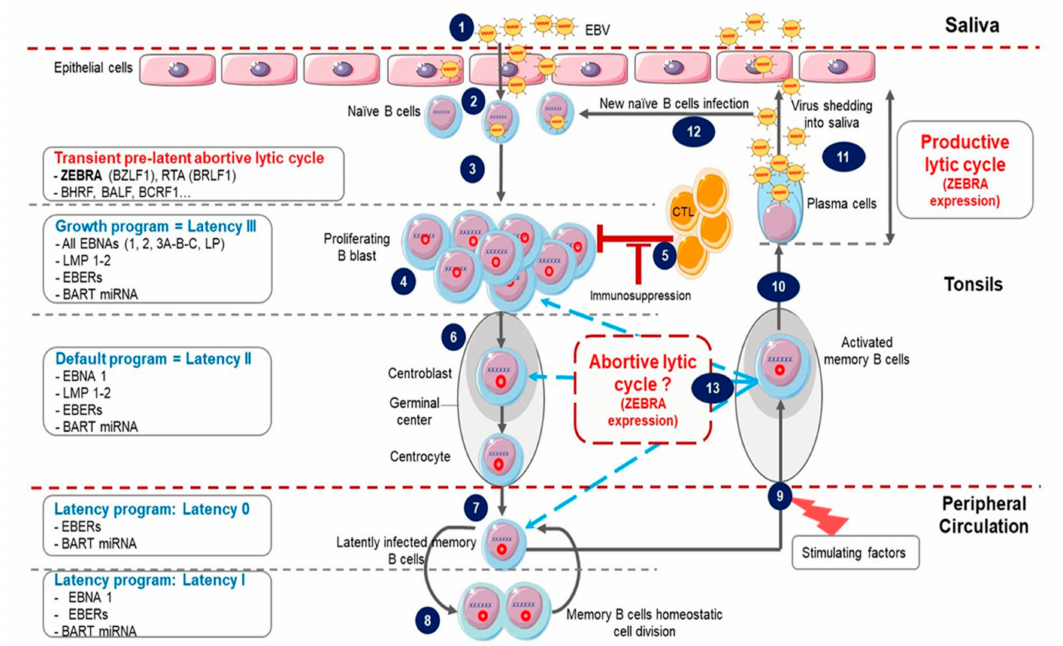
Figure 1. Epstein-Barr Virus (EBV) life cycle. ( 1 ) Infection occurs after the contact with an infected saliva. ( 2 ) After initial infection of oropharyngeal epithelial cells, the virus passes into the underlying lymphoid tissue where it infects naive B cells. ( 3 ) This immediately triggers the transient pre-latent lytic cycle with expression of ZEBRA and other lytic genes involved in resistance to apoptosis and evasion from the immune system. ( 4 ) Infected naive B cells become proliferating B blasts through the growth program (latency III) where all latency proteins are expressed. ( 5 ) Cytotoxic T lymphocytes (CTL) trigger a strong immune response (which is impaired during immunodeficiency) to eliminate EBV-infected B cells. ( 6 ) Proliferating B blasts migrate into the germinal center (GC) and activate the default transcription program (latency II) where latency protein expression is restricted to EBNA1, LMP1 and LMP2. They di ff erentiate into centroblasts and then centrocytes. ( 7 ) Centrocytes leave the GC and di ff erentiate into memory B cells circulating in peripheral blood. These cells have turned o ff the expression of all viral proteins (latency 0). ( 8 ) Occasionally, circulating EBV-positive memory B cells express EBNA1 during homeostatic cell division to ensure viral genome replication and segregation into daughter cells. ( 9 ) Following stimulation, latently infected memory B cells can be recruited into GC. ( 10 ) Activated EBV-positive memory B cells can di ff erentiate into plasma cells, reactivate the virus and undergo productive lytic cycle that leads to ( 11 ) viral shedding into saliva and ( 12 ) new naive B cells infection. ( 13 ) Activated EBV-positive memory B cells reintegrate the pool of memory B cells. It is not clear whether in vivo stimulated EBV-positive memory B cells which have not di ff erentiated into plasma cells undergo an abortive lytic cycle (ZEBRA and early gene expression without viral production) before reintegrating the pool of memory cells. It is also not clear whether these cells successively re-express di ff erent latency programs in the GC in vivo before reintegrating the pool of memory